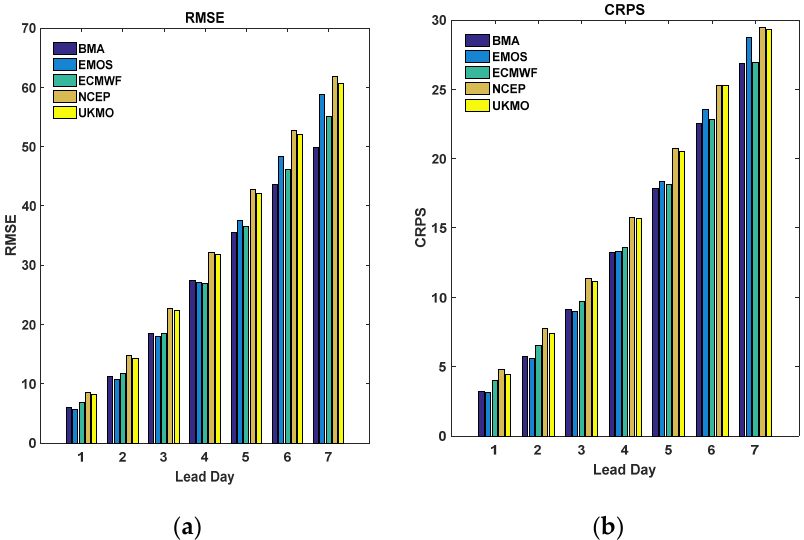
Figure 5. Mean verification for the BMA, EMOS and raw EPS forecasts of the 500 hPa geopotential height with lead times of 1–7 days (units: gpm) for the ( a ) RMSE and ( b ) continuous ranked probability score (CRPS).